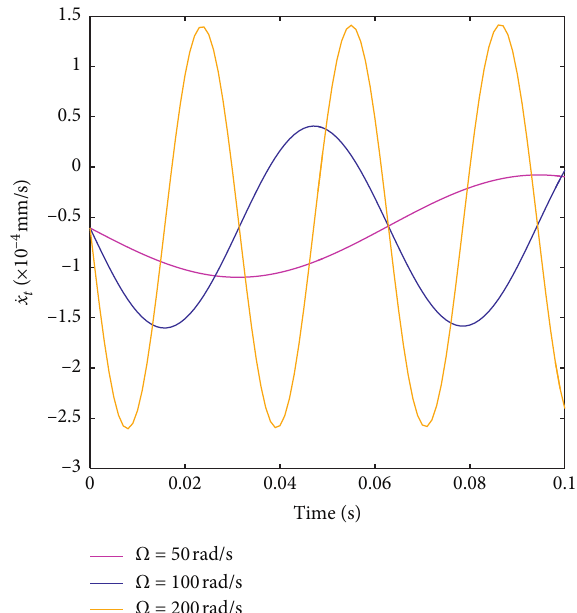
Figure 5: Changes of movement velocity of rock surface with time in different Ω .